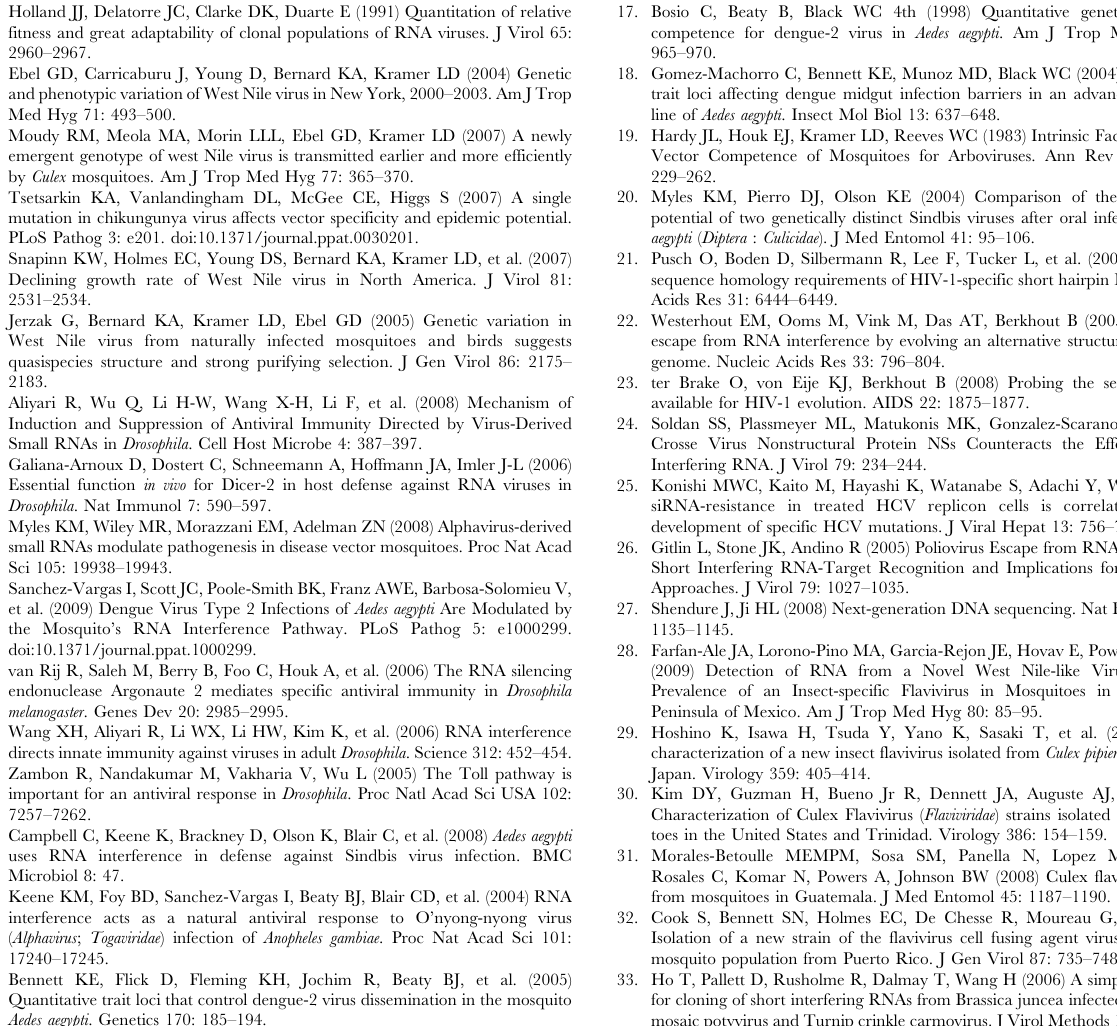
Table S2 Alignment of sRNA reads against viruses not used in these studies. * For all four sRNA libraries generated in these studies (WNV-infected and